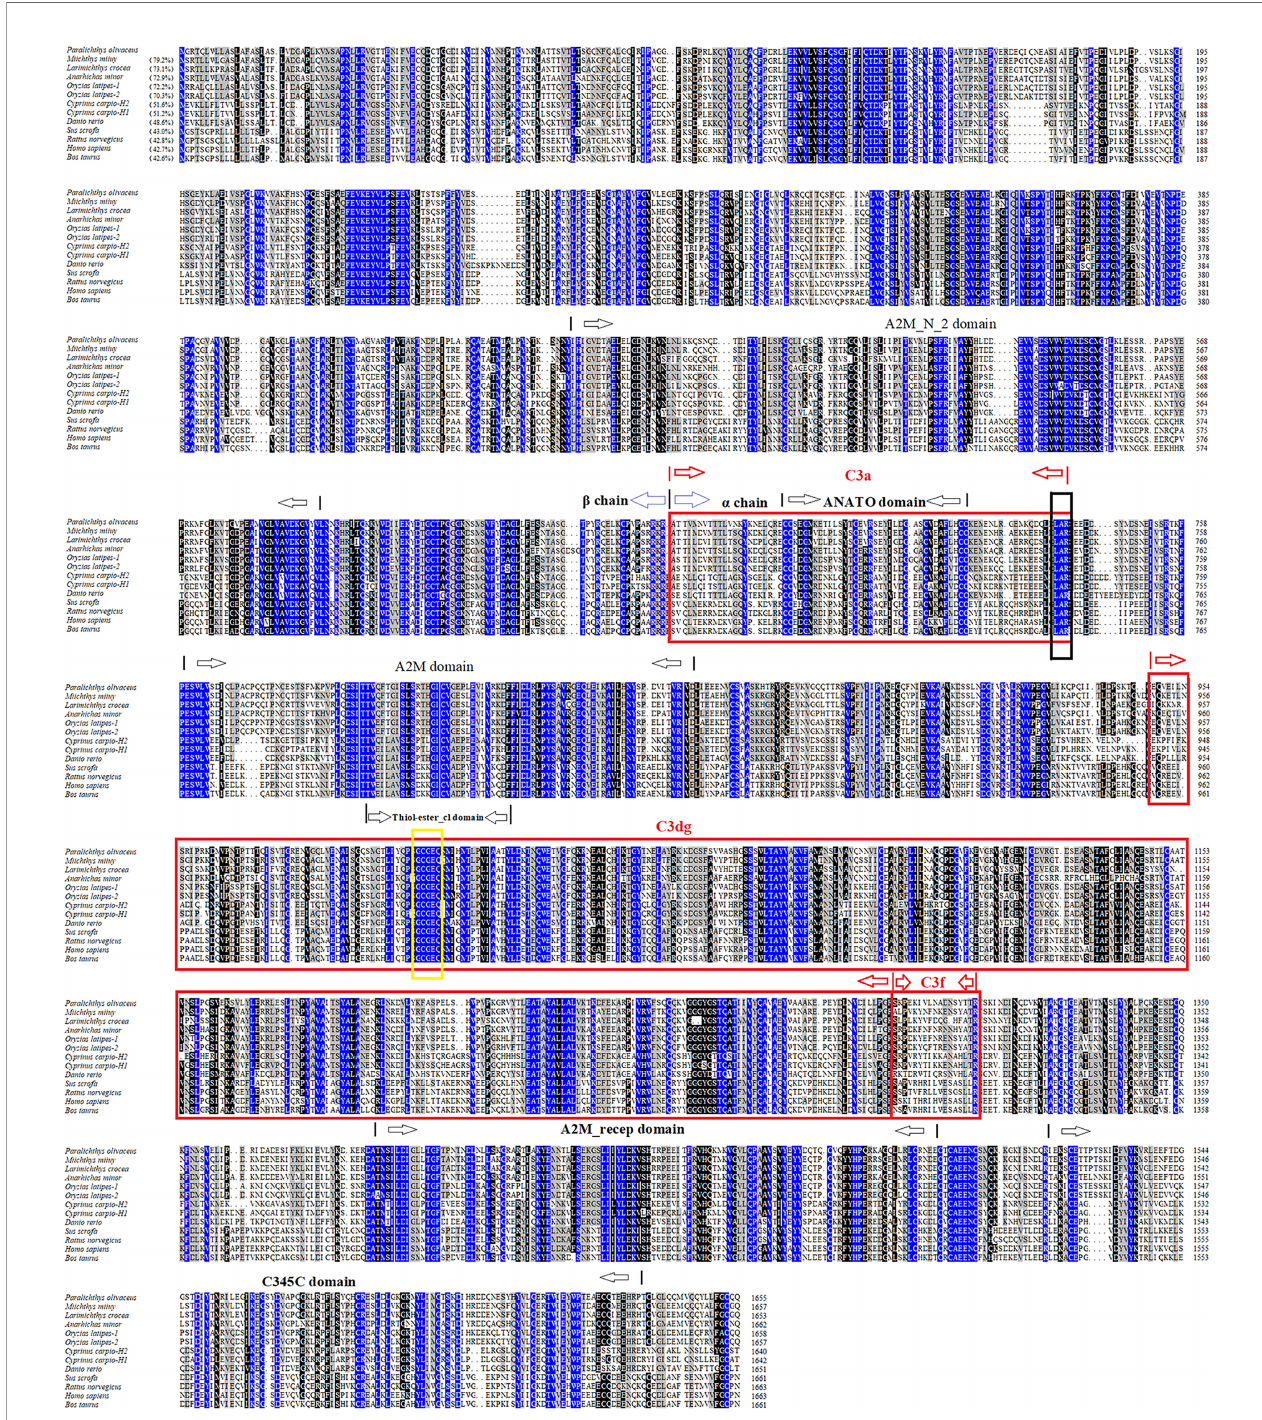
FIGURE 1 | Sequence alignment of PoC3 homologues. Dots denote gaps introduced for maximum matching. Numbers in brackets indicate overall sequence identities between PoC3 and the compared sequences. The consensus residues are in blue, the residues that are ≥ 75% identical among the aligned sequences are in black, and the residues that are ≥ 50% identical among the aligned sequences are in grey. The A2M_N_2, ANATO, A2M, Thiol-ester_cl, A2M_recep and C345C domains are marked with black arrows. Derived C3 activation fragment C3a, C3dg, and C3f are marked with red box. The C3 convertase cleavage site of C3 is marked in black box. The highly conserved sequence GCGEQ of the C3 family is marked with a yellow box. The GenBank accession numbers of the aligned sequences are as follows: PoC3, BAA88901.1; Miichthys miiuy , AFC89899.1; Larimichthys crocea , AHZ41228.1; Anarhichas minor , CAC29154.1; Oryzias latipes -1, NP_001098552.1; Oryzias latipes -2, NP_001098553.1; Cyprinus carpio- H2, BAA36620.1; Cyprinus carpio- H1, BAA36619.1; Danio rerio , NP_001032313.2; Sus scrofa , NP_999174.1; Rattus norvegicus , NP_058690.2; Homo sapiens , NP_000055.2; Bos taurus ,